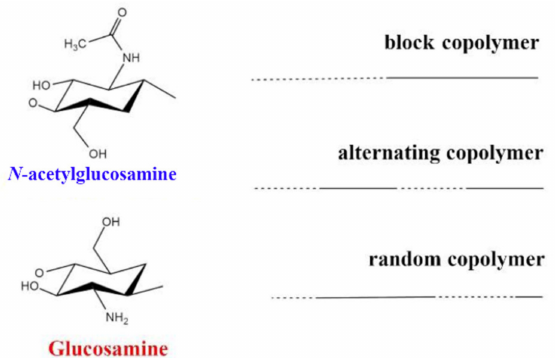
Figure 1. Natural sources of chitosan: animals (seafood waste, mainly crabs and shrimps) and mushrooms (from left to right: Pleurotus Ostreatus, Aspergillus Niger, Penicillum Citrinum, Fusarium Oxysporum).